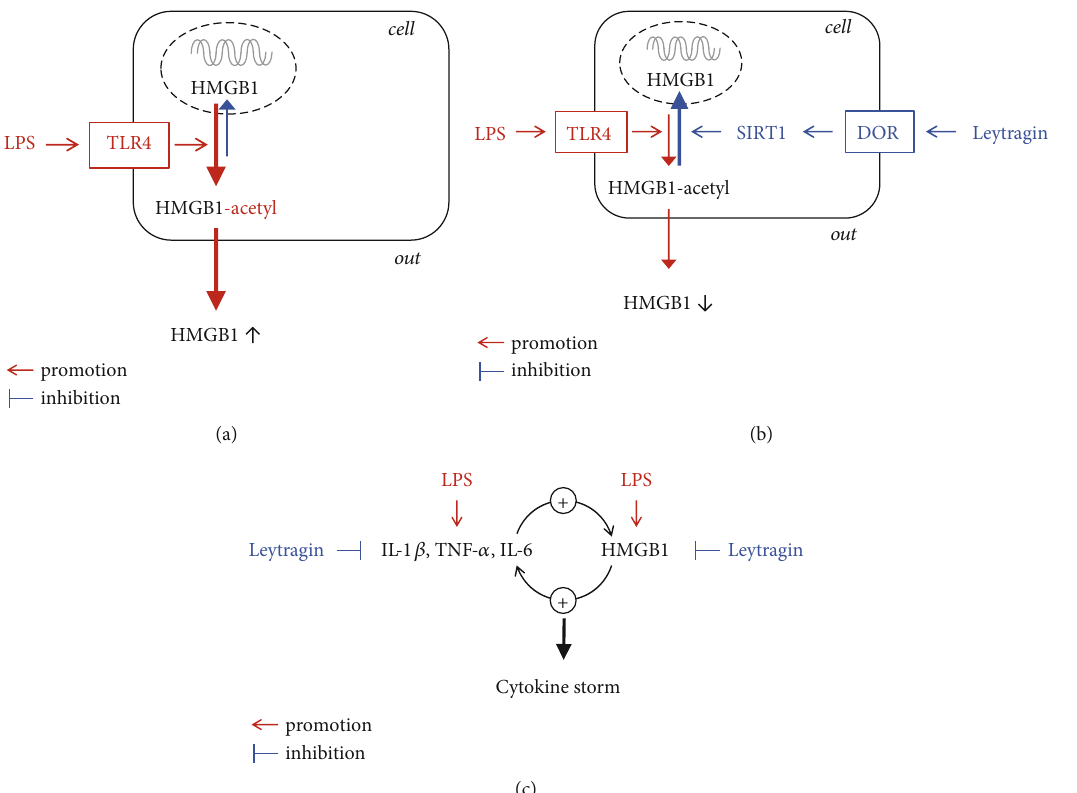
Table S1: oligonucleotide primers and PCR probes used in the study. Table S2: two-way ANOVA analysis of leytragin e ff ects on mRNA levels of cytokines in the lungs of LPS- induced mice. Fig. S1: Kaplan-Meier survival curves (adapted from Karkischenko et al. [33] with permission